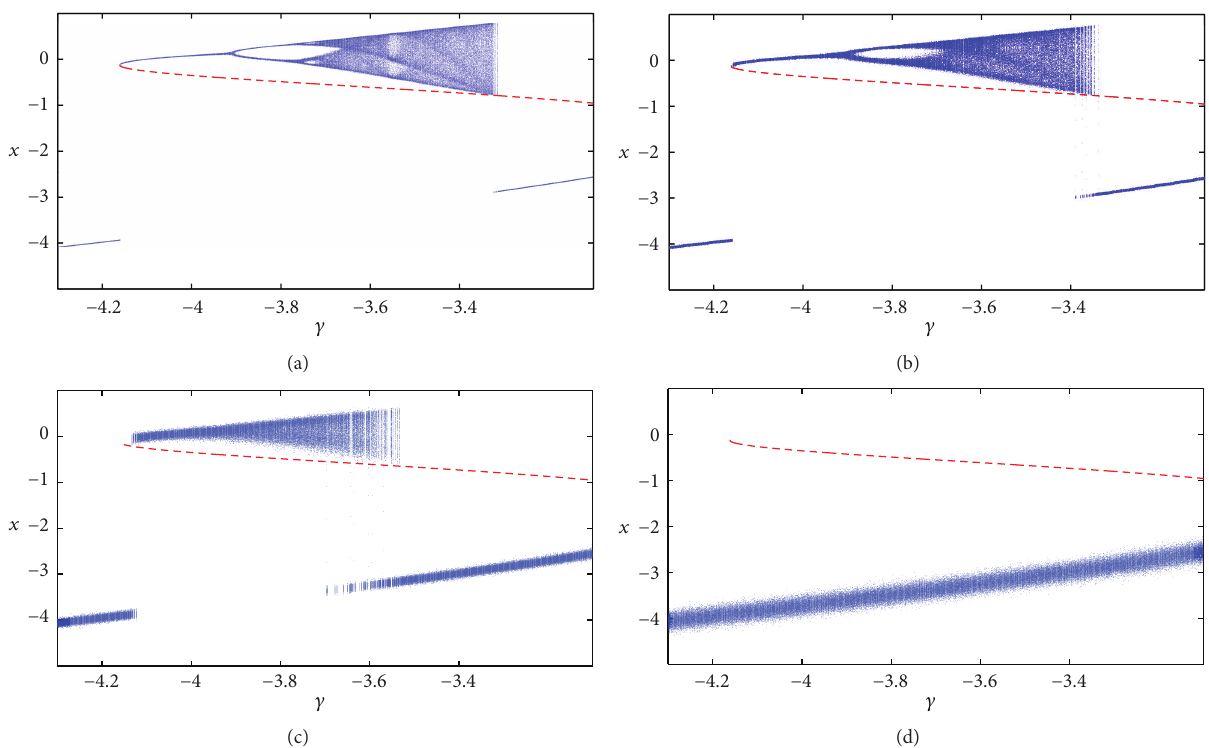
Figure 2: Random states of stochastic Rulkov model for (a) 𝜀 = 0.003 , (b) 𝜀 = 0.01 , (c) 𝜀 = 0.04 , and (d) 𝜀 = 0.1 .